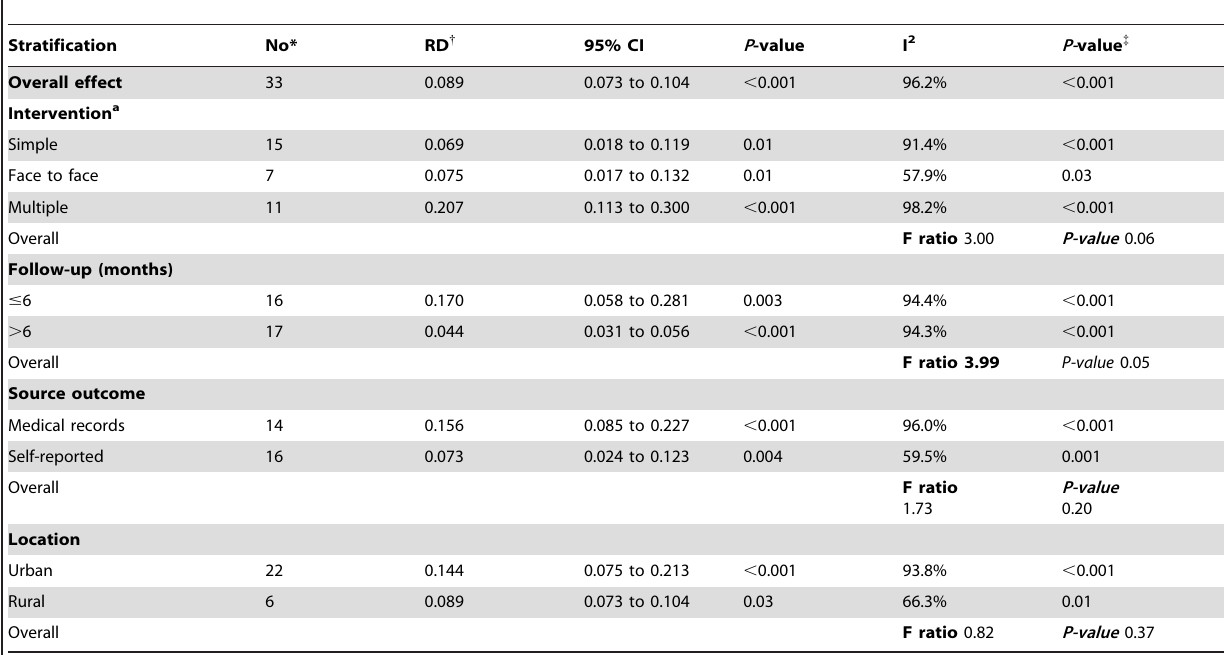
Table 4. Results from overall and stratified random effects meta-analyses for the associations between intervention and mammography uptake in low income